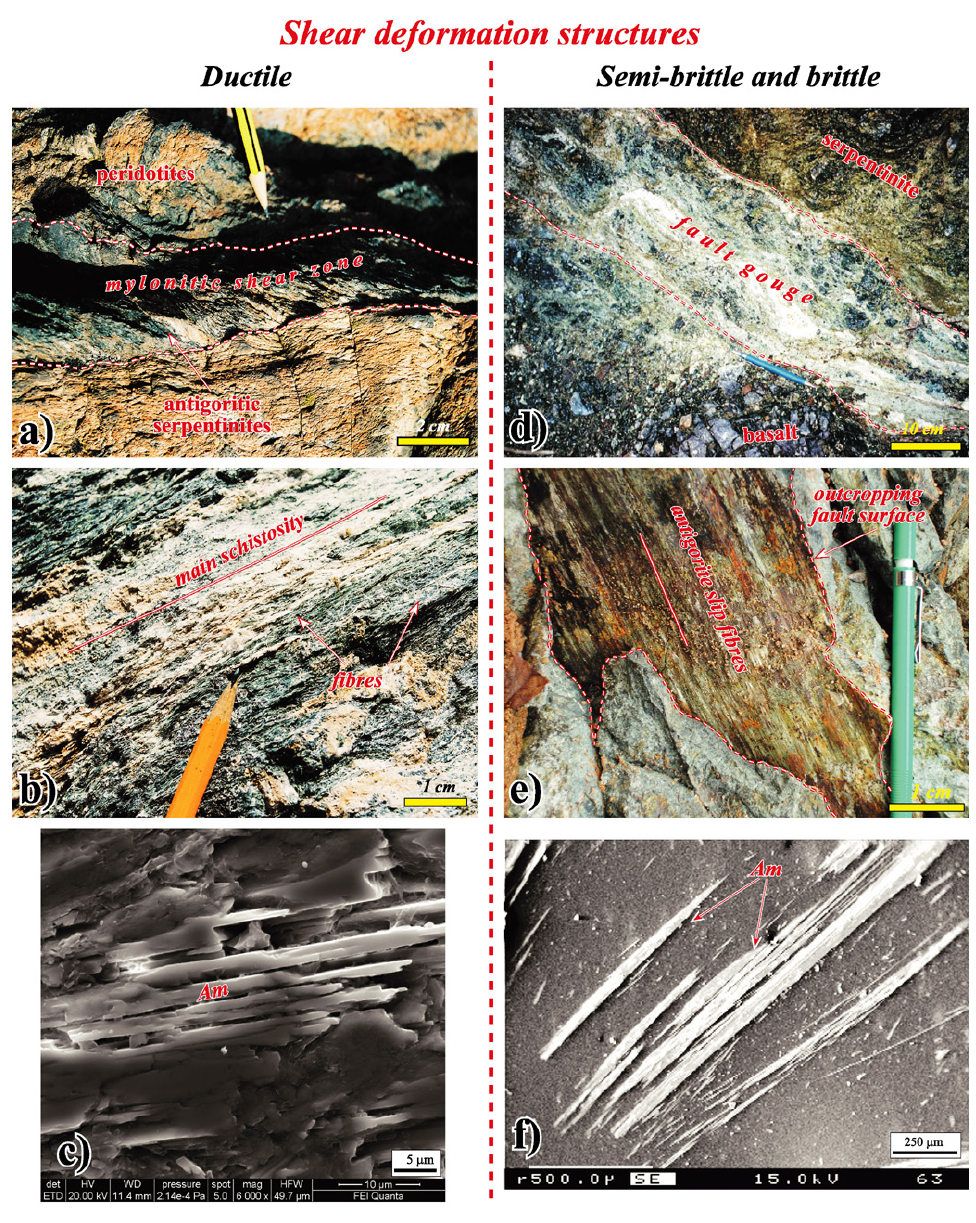
Fig. 5. Examples of ductile and brittle shearing in ophiolites. (a) Meso-scale ductile mylonitic shear zone with development of serpentinites in massive lherzolites; (b) meso-scale pervasive schistosity in serpentinites accomplished by occurrence of free asbestiform minerals (probably tremolite); (c) SEM image of strongly aligned amphibole in foliated microfabric; (d) decimetric-width fault gouges in serpentinites with fine-grained antigorite (the white horizons); (e) antigorite slip fibres developed on fault surface in metagabbros; (f) BSE images of fibrous amphiboles showing fracturing in parallel thinner fibres. Mineral abbreviation: Am: